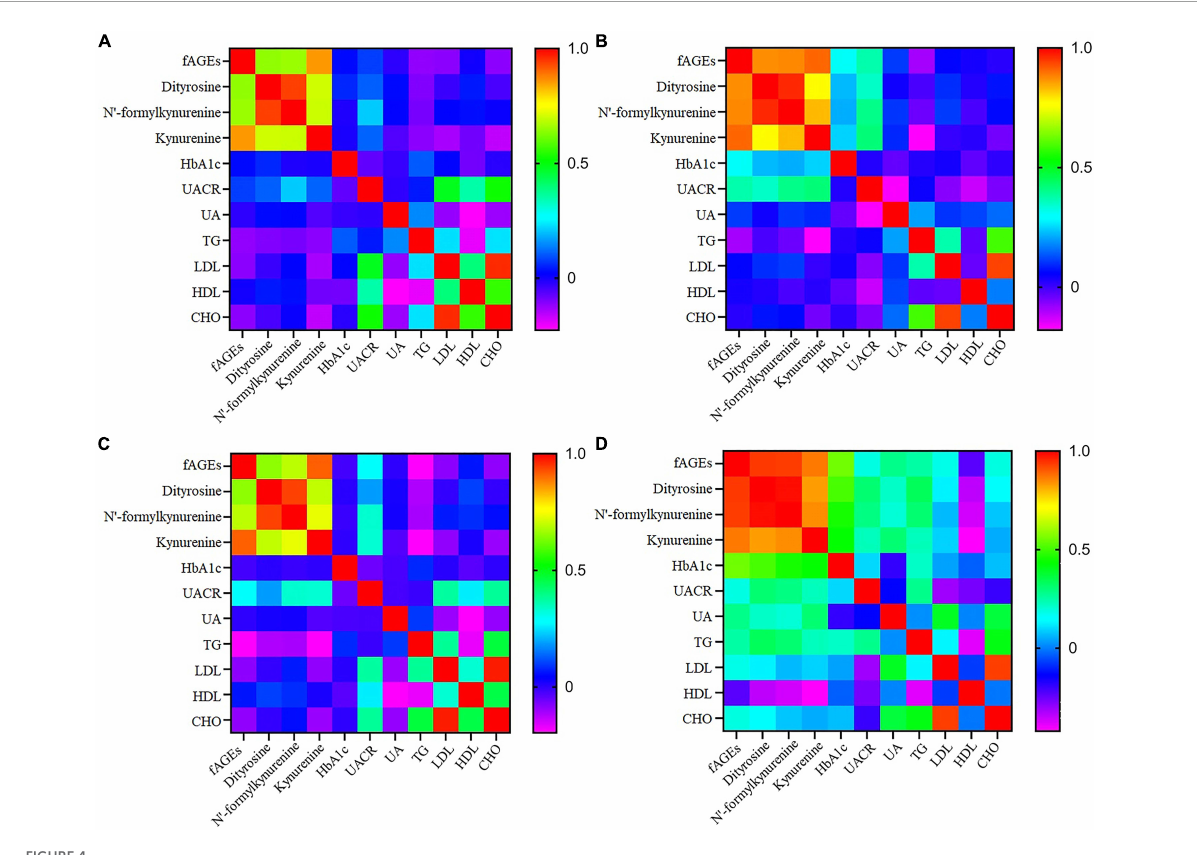
FIGURE4 The heatmap of correlation coefficient of fluorescent advanced glycation end products (fAGEs), dityrosine, N’-formylkynurenine and kynurenine, HbA1c, UACR, UA, TG, LDL, HDL, and CHO in T2DM with non-smokers (A) , smokers (B) , CIMT < 1 (C) , and CIMT ≥ 1 (D)